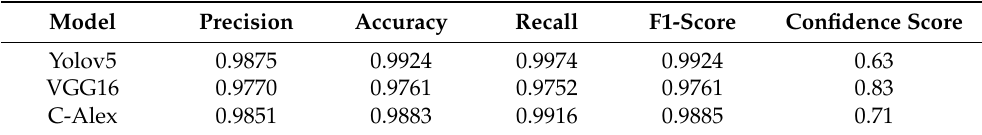
Table 2. Various evaluation parameters of the three models.